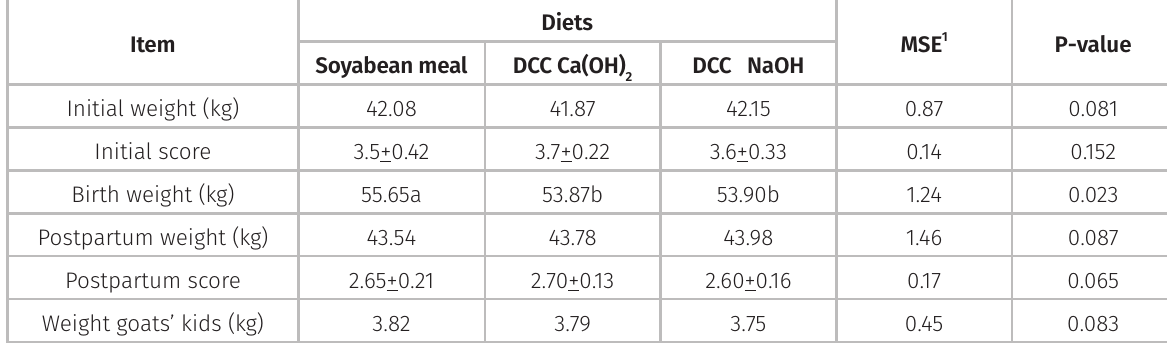
Table IV. Weight and body condition score of pregnant goats fed diets containing detoxified castor (DCC) by different alkali replacing soybean meal during gestation and weight of goats